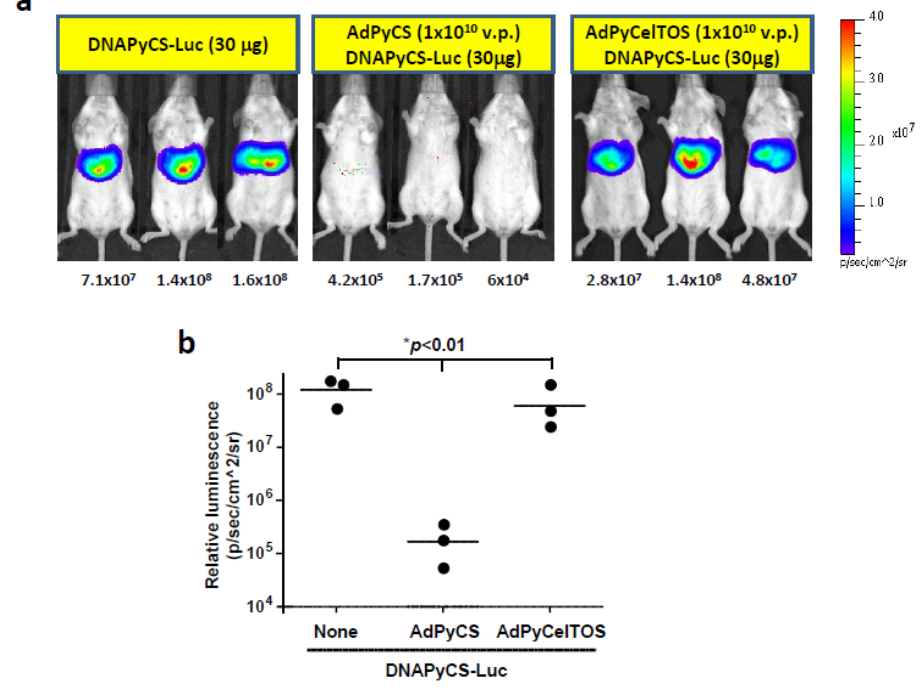
Figure 3. Luciferase expression in AdPyCS-immunized mice, AdPyCelTOS-immunized mice, or naïve mice, upon HTV injection of DNAPyCS-Luc. ( a ) Noninvasive bioluminescence image shows the inhibition of DNAPyCS-Luc induced luciferase expression in mice by a prior single immunizing dose of AdPyCS, but not of AdPyCelTOS. Three day after the HTV injection with DNAPyCS-Luc, mice were anesthetized and injected with D-luciferin, and the luciferase intensity was optically imaged; ( b ) Quantification of the bioluminescent signal intensity in AdPyCS-immunized mice, AdPyCelTOS-immunized mice, or naïve mice, upon HTV injection of